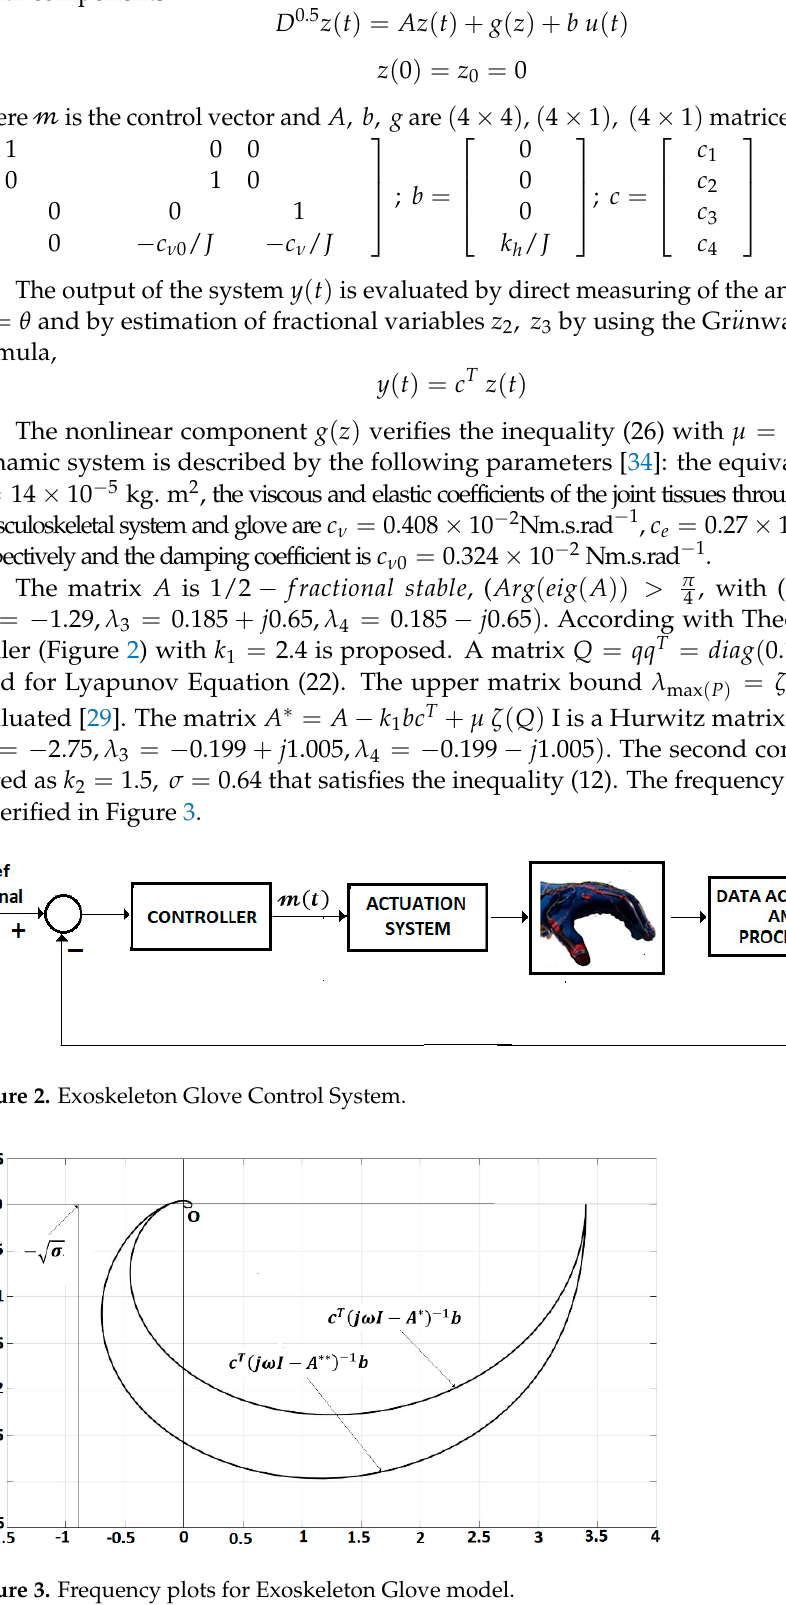
Figure 3. Frequency plots for Exoskeleton Glove model.